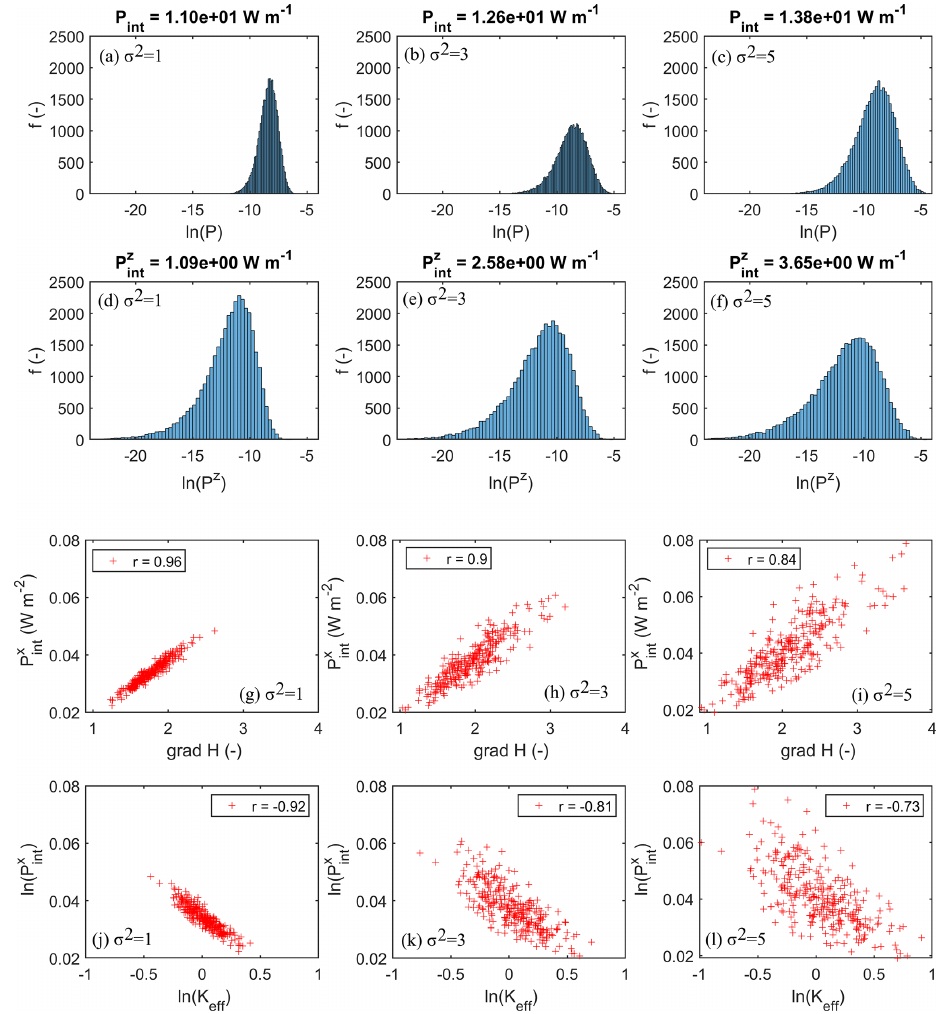
Figure 4. Histogram of log power ln( P ) (a, b, c) and log power in the vertical water flux ln( P z ) (e, f, g) as a function of the variance σ 2 . Integral power P x in the total downstream water flux, plotted against the laterally averaged head gradient (g, h, i) and ln( P x int of the log of the transversally averaged K , ln( K eff ) (j, k, l)